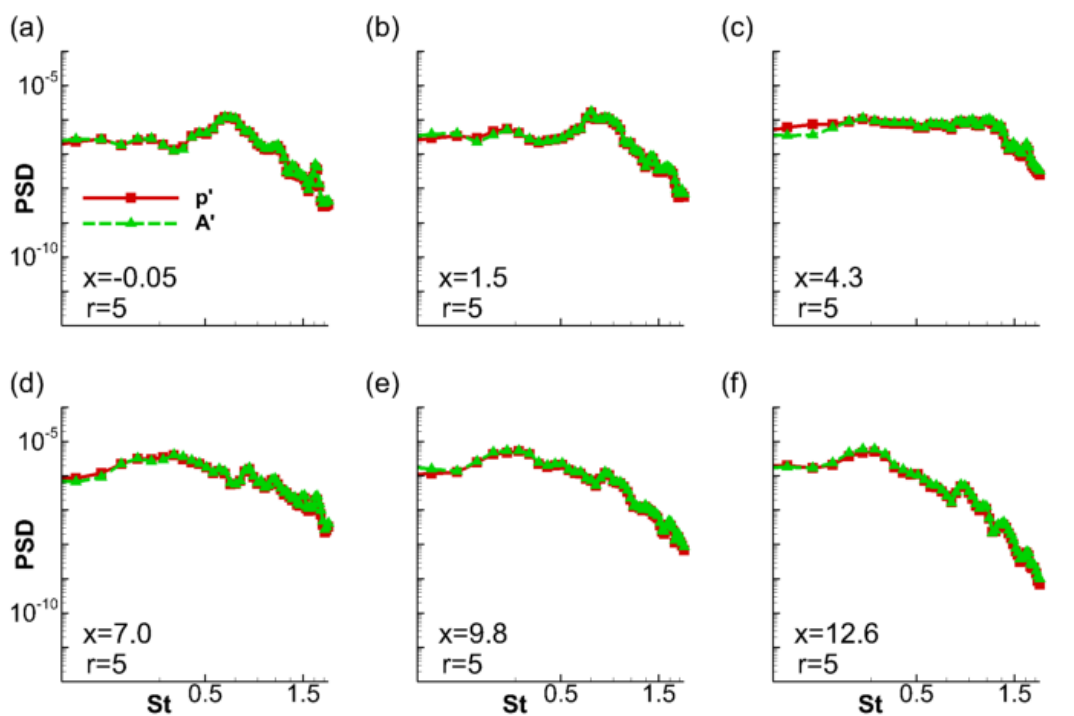
Figure 7. Comparison of PSDs obtained from pressure fluctuations and the acoustic mode at various locations in the computational nearfield, as indicated in each frame. Frames a - f share the same abscissa and